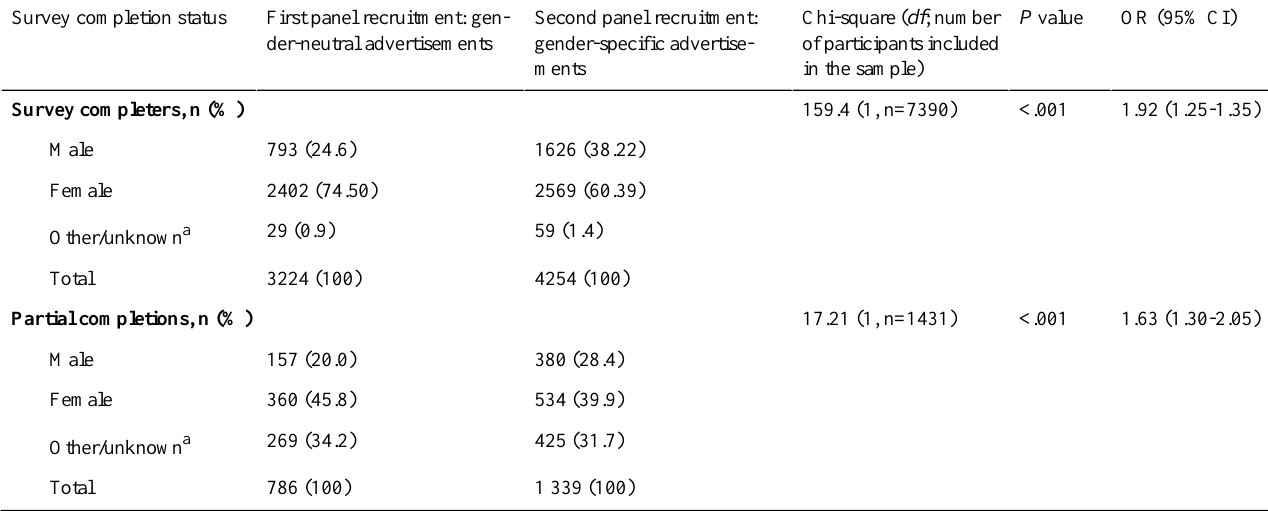
Table 4. Gender of participants across panels of recruitment.